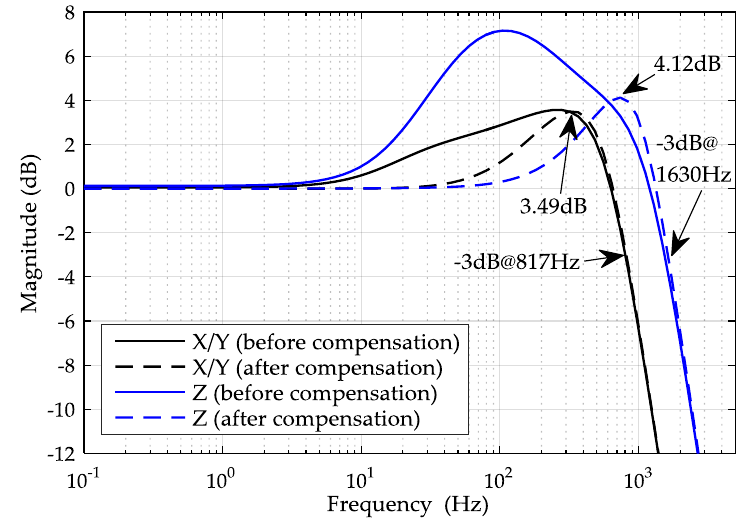
Figure 10. Simulated closed-loop frequency responses of the three-axis MESA in vacuum.